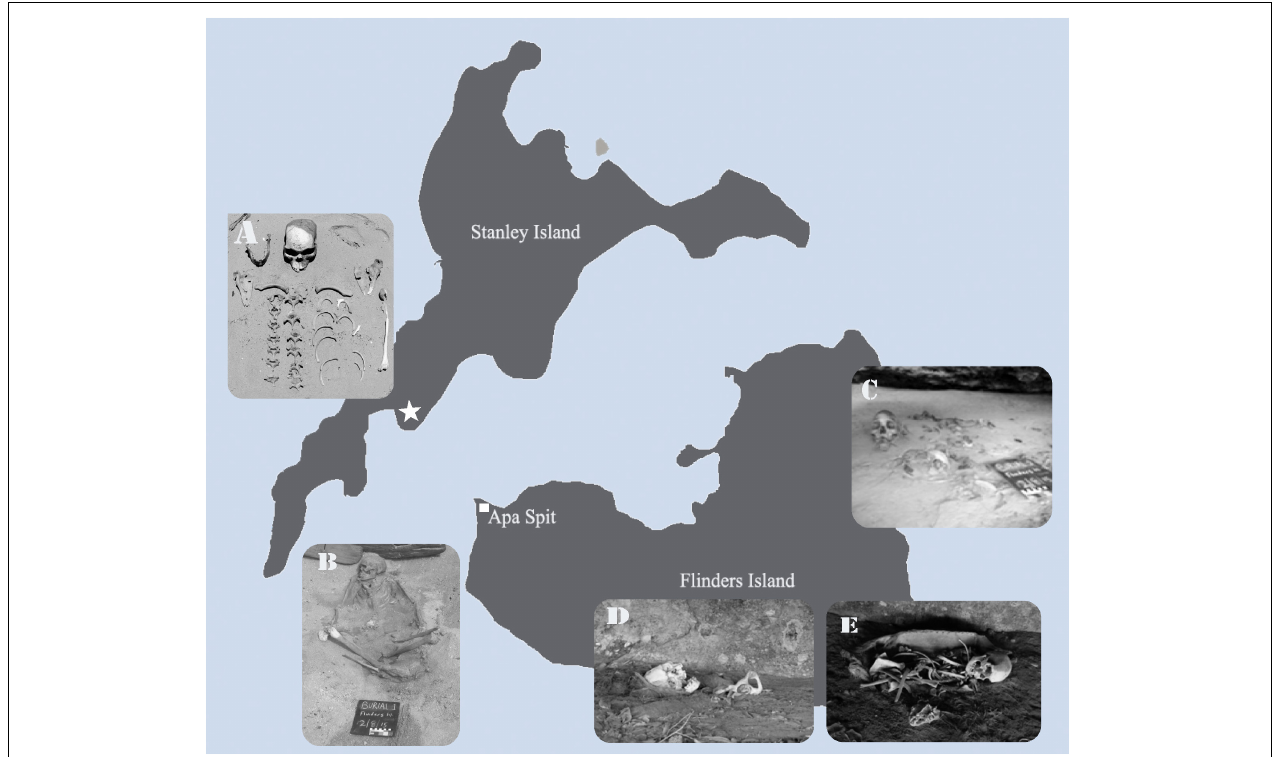
FIGURE 2 | Flinders Island Group burials. (A) Stanley Island female (STI1) remains, the burial location is indicated by the hexagon on the map. (B) Flinders Island adult male individual (FLI1) beach burial in the area of Apa Spit. (C) A set of remains found inside a rock-shelter (FLI2), located close to the beach on the east coast of Flinders Island. The second rock-shelter in the north coast of Flinders island where (D) FLI3 and (E) FLI4 both were